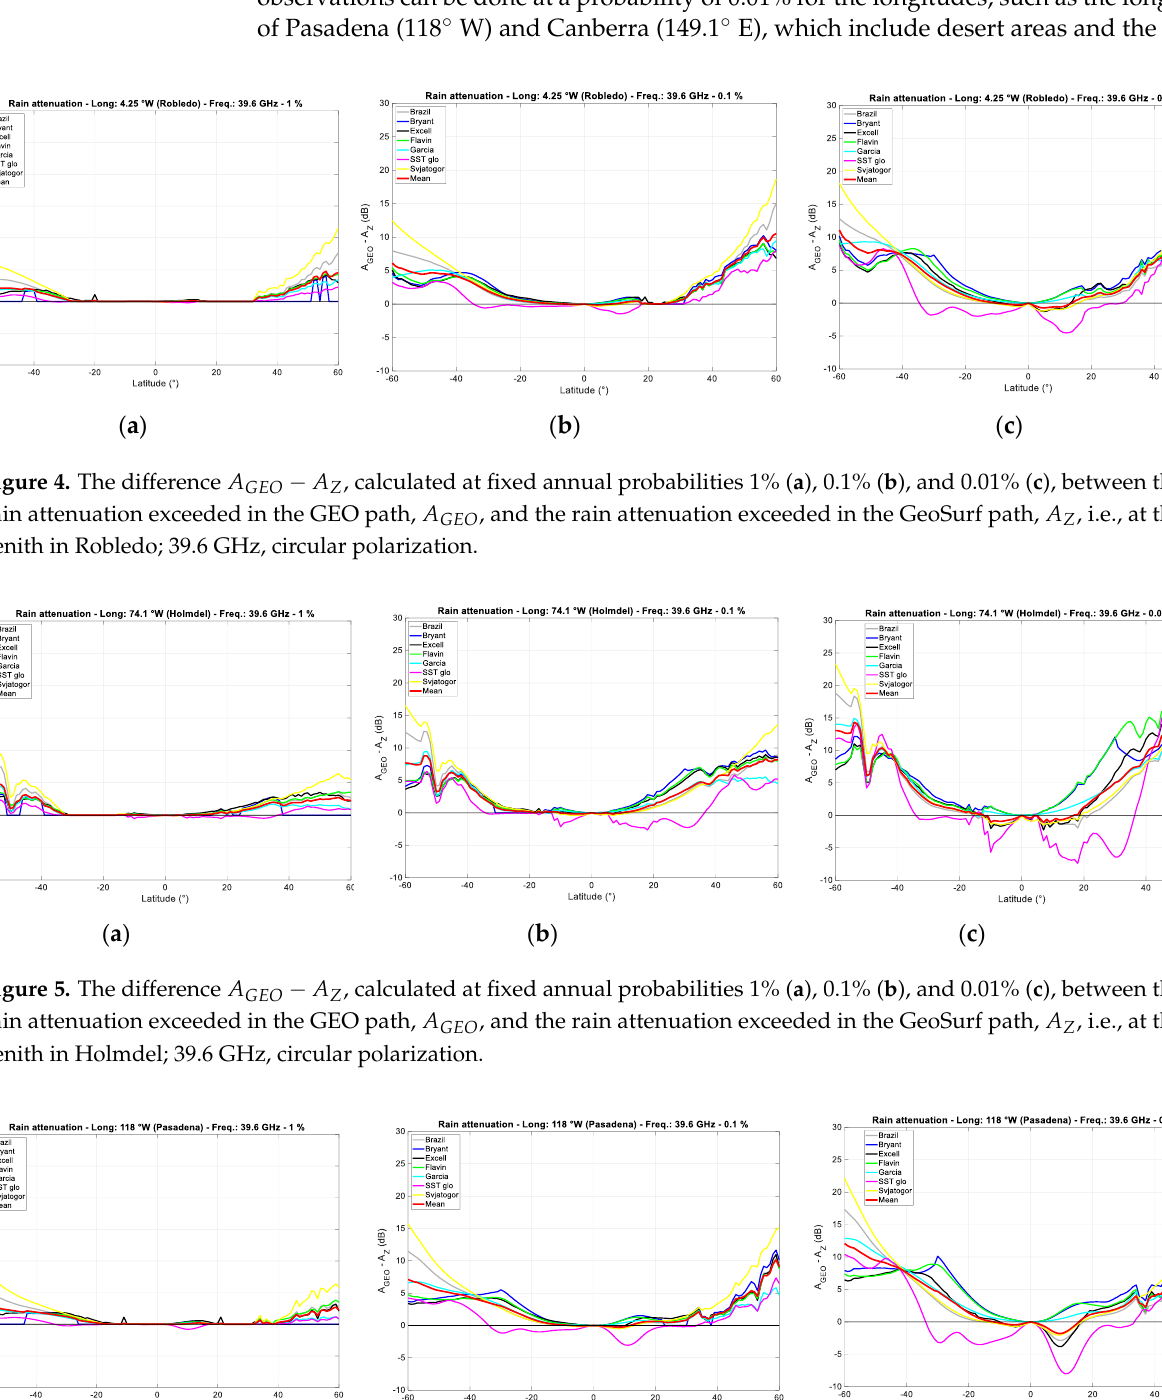
( c ) Figure 6. The difference 𝐴 𝐺𝐸𝑂 − 𝐴 𝑍 , calculated at fixed annual probabilities 1% (a), 0.1% (b), and 0.01% (c), between the rain attenuation exceeded in the GEO path, 𝐴 𝐺𝐸𝑂 , and the rain attenuation exceeded in the GeoSurf path, 𝐴 𝑍 , i.e., at the zenith in Pasadena; 39.6 GHz, circular polarization.